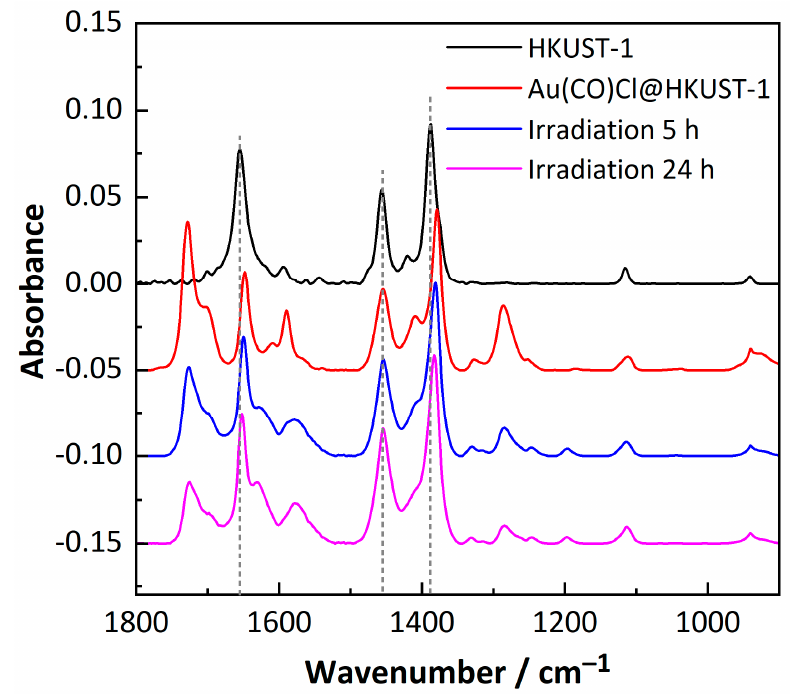
Figure 7. IR spectra for empty HKUST-1 SURMOF (black), after loading with Au(CO)Cl (red) and exposed to UV light for 5 h (blue) and exposed to UV light for 24 h (magenta). exposed to UV light for 5 h (blue) and exposed to UV light for 24 h